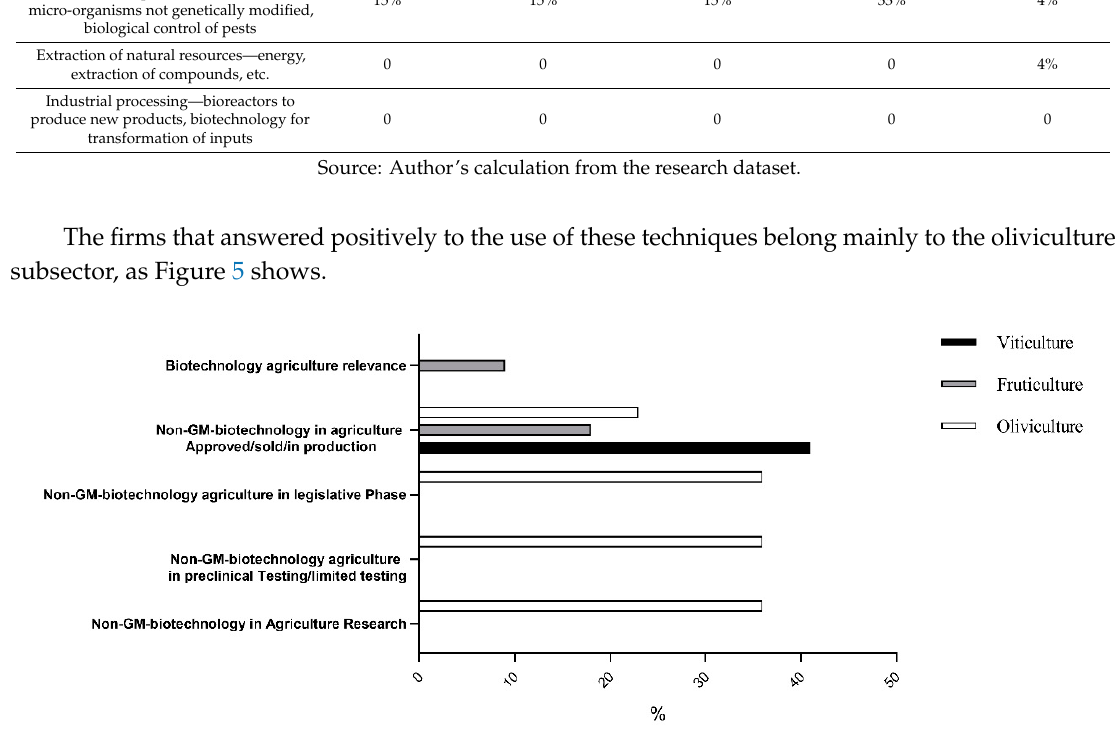
Table 2. Types of biotechnological methods applied to the agri-food sector.